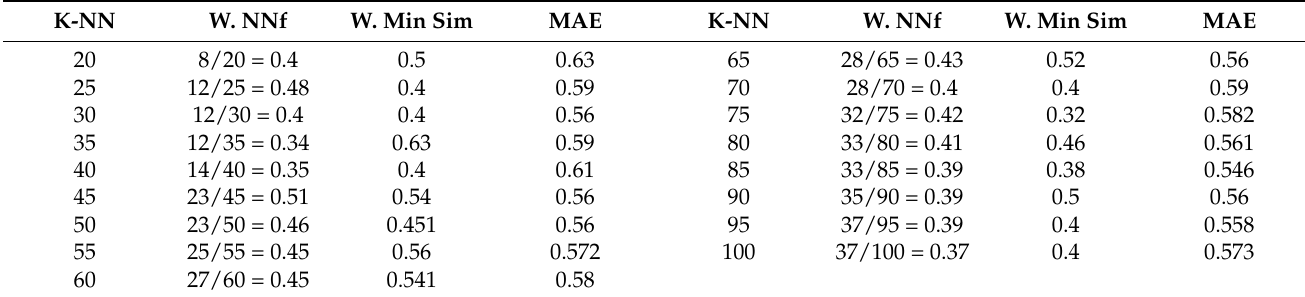
Table 9. MAE, NNf, and w min sim of adaptive R2-yahoo music dataset.